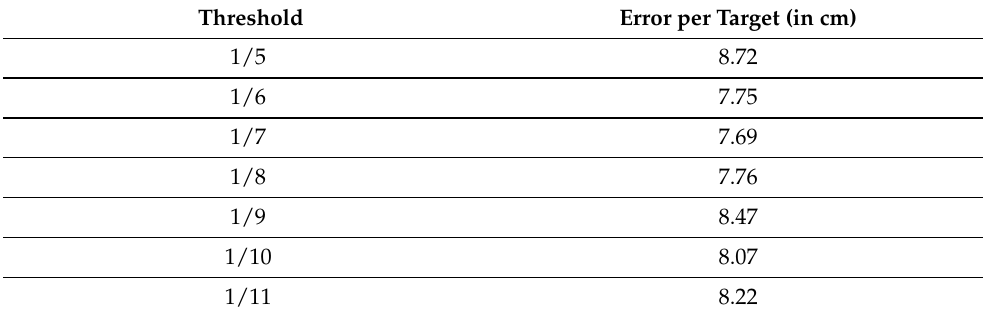
Table 1. Impact of different threshold level on performance of the proposed algorithm.